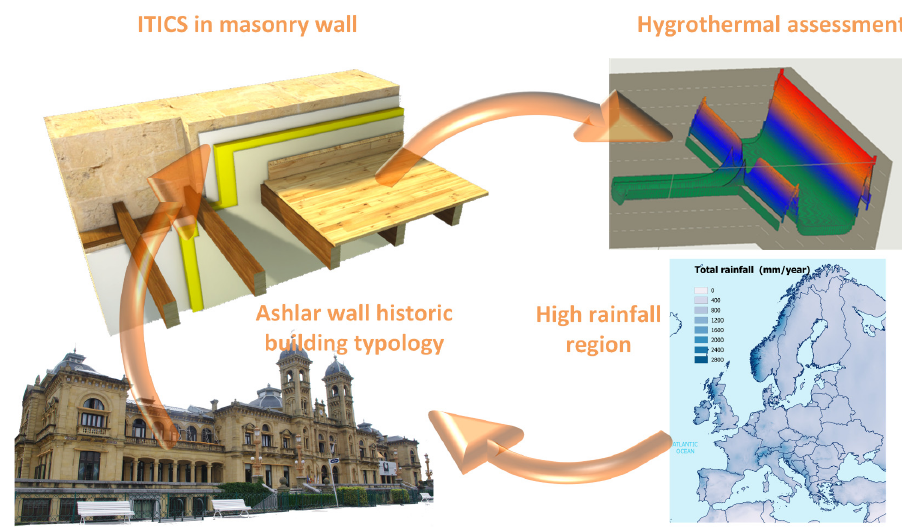
Figure 2. Carried out procedure for the hygrothermal assessment of ITICS solutions.